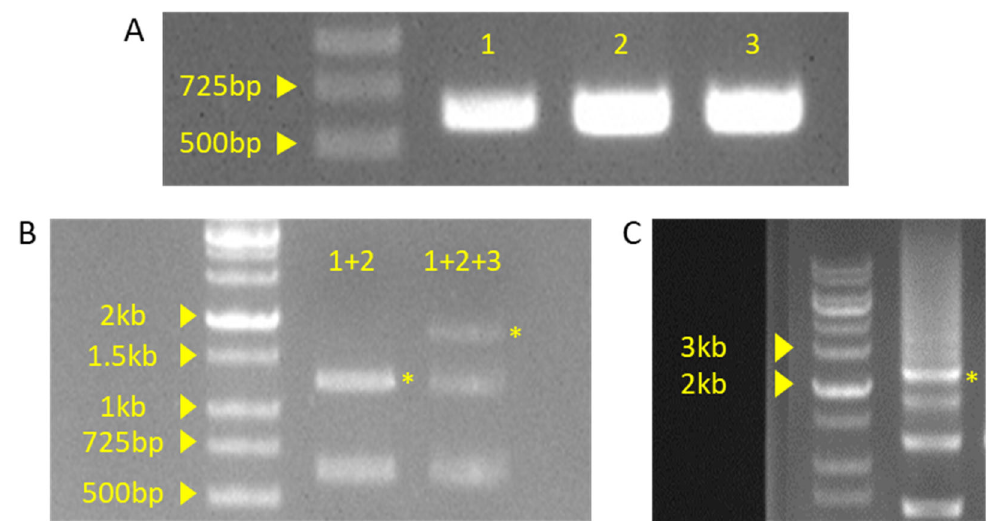
Figure 7. Gel picture of PCR or ligation products. ( A ) PCR product of insert fragment. Each fragment numbers indicate sequential order. 1: DT1 and DT2 primer set used fragment, 2: DT3 primer set used fragment, 3: DT4 primer set used fragment. ( B ) Product of Golden Gate reaction. +indicate ligation of insert fragment. ( C ) Product of pHEE401E vector colony PCR. Yellow asterisk indicated by the expected band is the expected result.